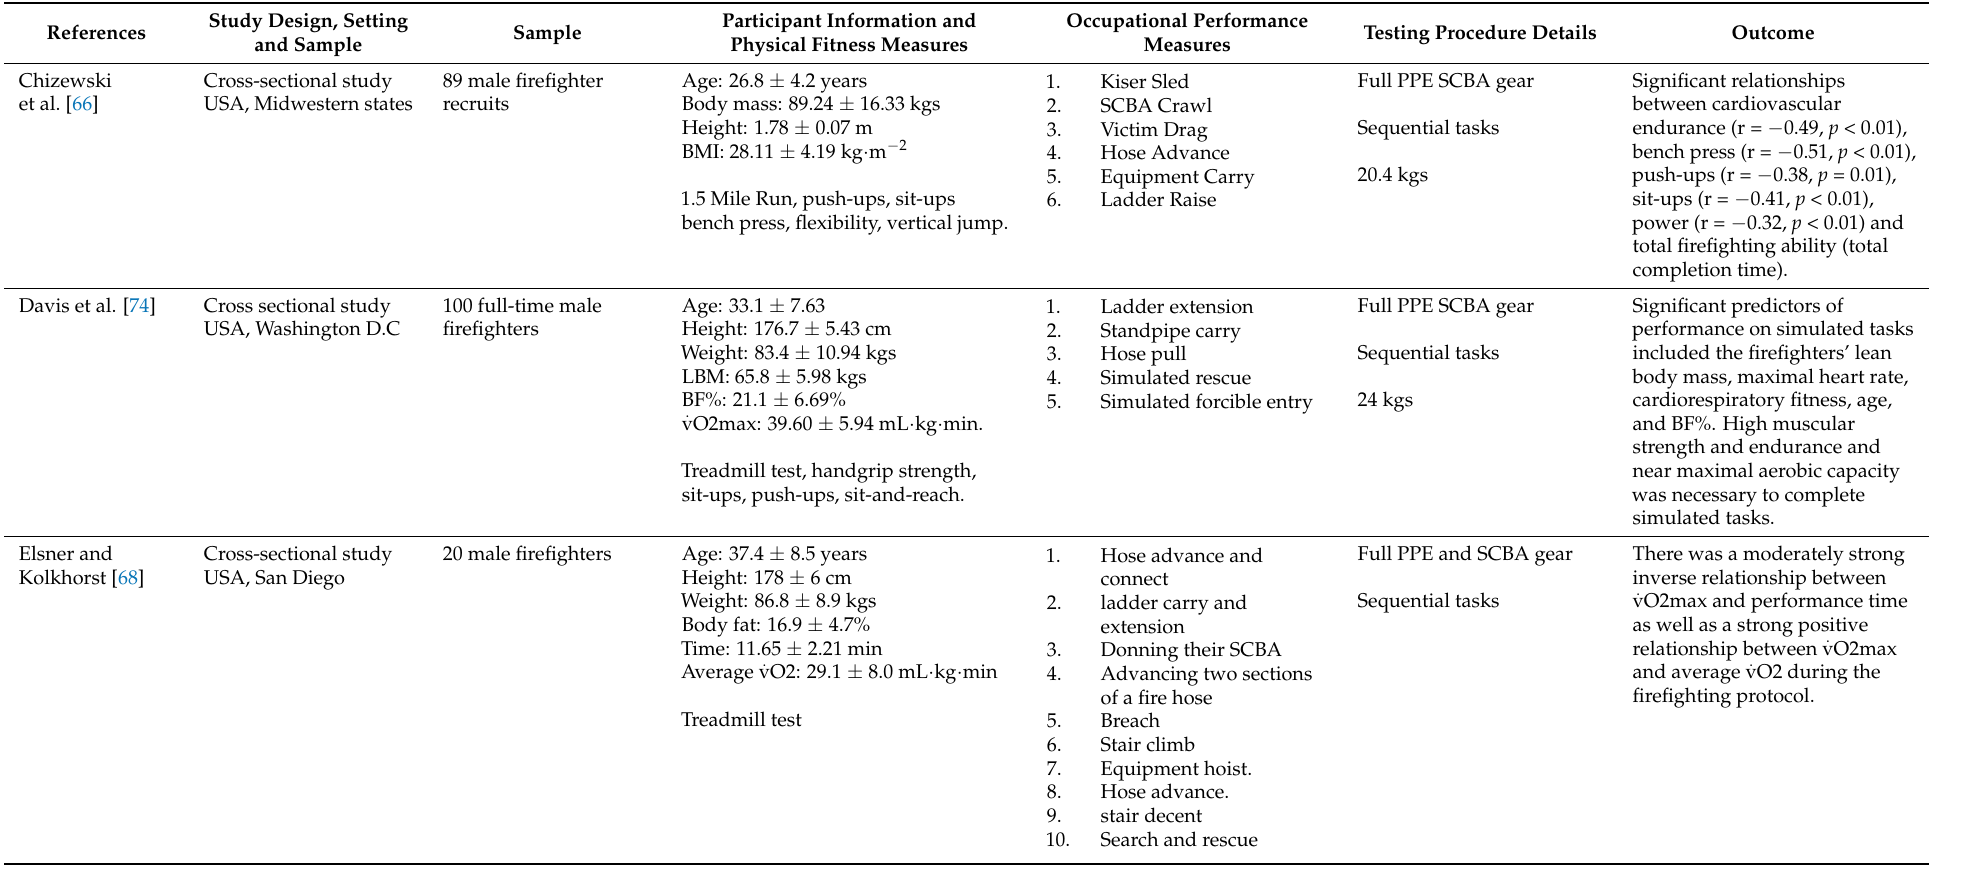
Table 3. Study characteristics of included